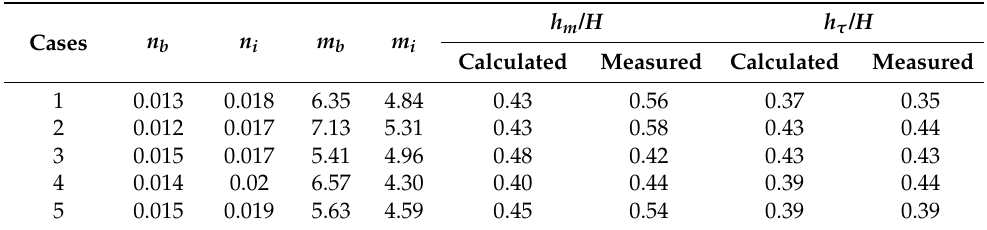
Table 3. Values of the model parameters to predict the velocity and Reynolds